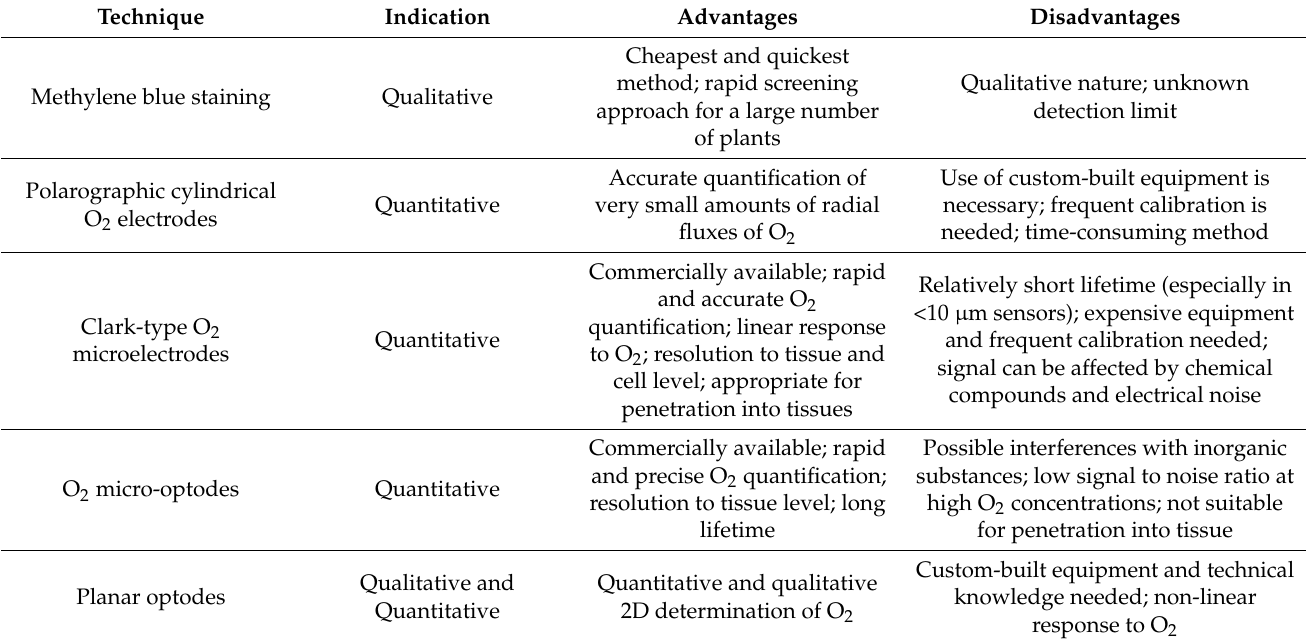
Table 1. Qualitative and quantitative methods for determination of radial O 2 loss from roots.